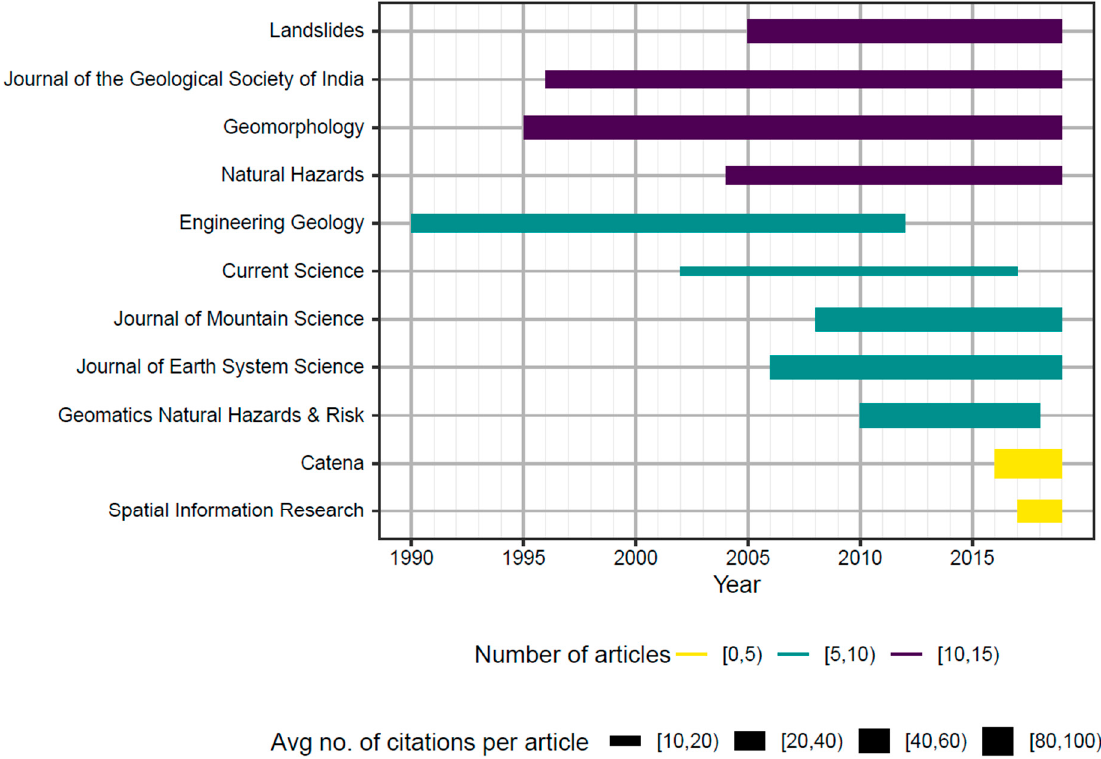
Figure 4. Distribution of the number of articles across the top 11 journals (out of 75). Horizontal bars depict the number of articles and its thickness denotes the average number of citations per article.